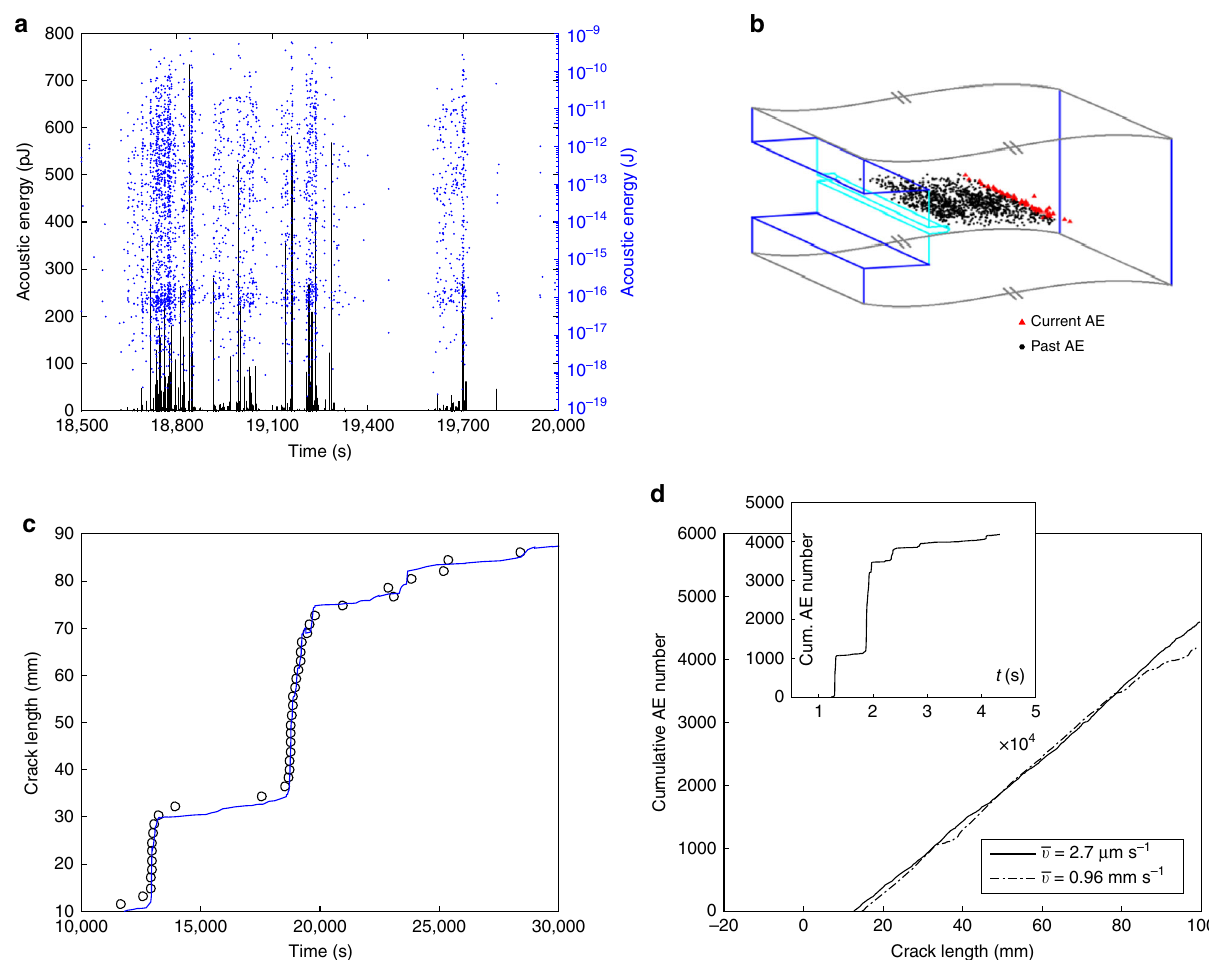
Fig. 1 Acoustic emission going along with crack propagation in a inhomogeneous solid. a Typical snapshot showing the time evolution of the energy of recorded AE in linear (black) and logarithmic (blue) scales. The snapshot duration is 1500 s while the whole experiment lasts 5 h 30 minutes. b Schematic of the advancing crack front with localized AE (Supplementary Movie 1). Black points show all sources localized from the starting of the experiment. Red points only show AE emitted over the last second. AE gather in the immediate vicinity of the propagating front. c This point is con fi rmed by comparing the time evolution of the crack front as detected from a side-view imaging (blue line) with that of the AE center of mass over a moving time window of one second (open circles). a , b , and c all concern the same experiment, where the microstructure length-scale is d = 583 μ m and the mean crack speed (cid:1) v ¼ 2 : 7 μ ms (cid:2) 1 . d main panel: Cumulative number of AE as a function of crack length in experiments with f d ¼ 583 μ m ; (cid:1) v ¼ 2 : 7 μ ms (cid:2) 1 g (plain)